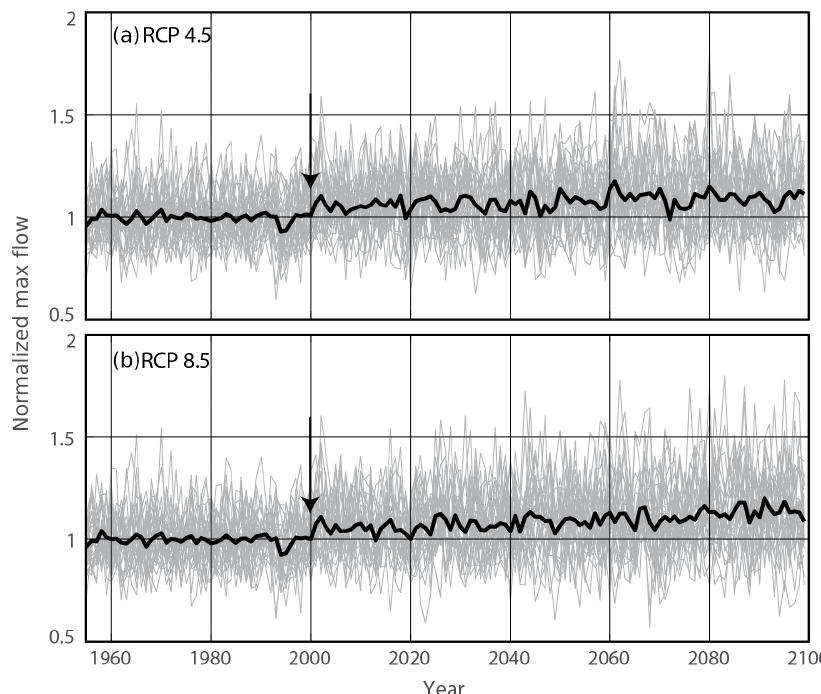
Figure 2. Trends in annual maximum flow across all stream segments in the CONUS. The thin grey lines represent annual maximum flow normalized to the 2001–2020 mean and averaged across all segments for each individual model. The thick black line represents the ensemble average. The step increase in the year 2000 for both RCPs (black arrow) is an artifact of the BCSD method. Accordingly, the baseline 1% AEP event was calculated from an early 21st century ensemble (see